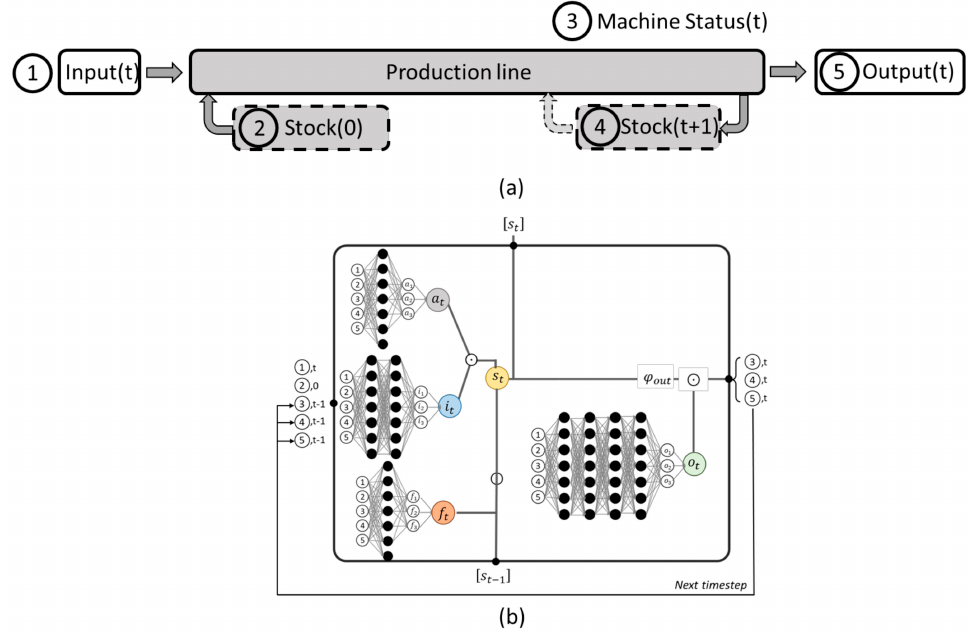
Figure 4. The machine learning model for production prediction ( a ) an illustration of the key parameters of the production line; ( b ) the LSTM